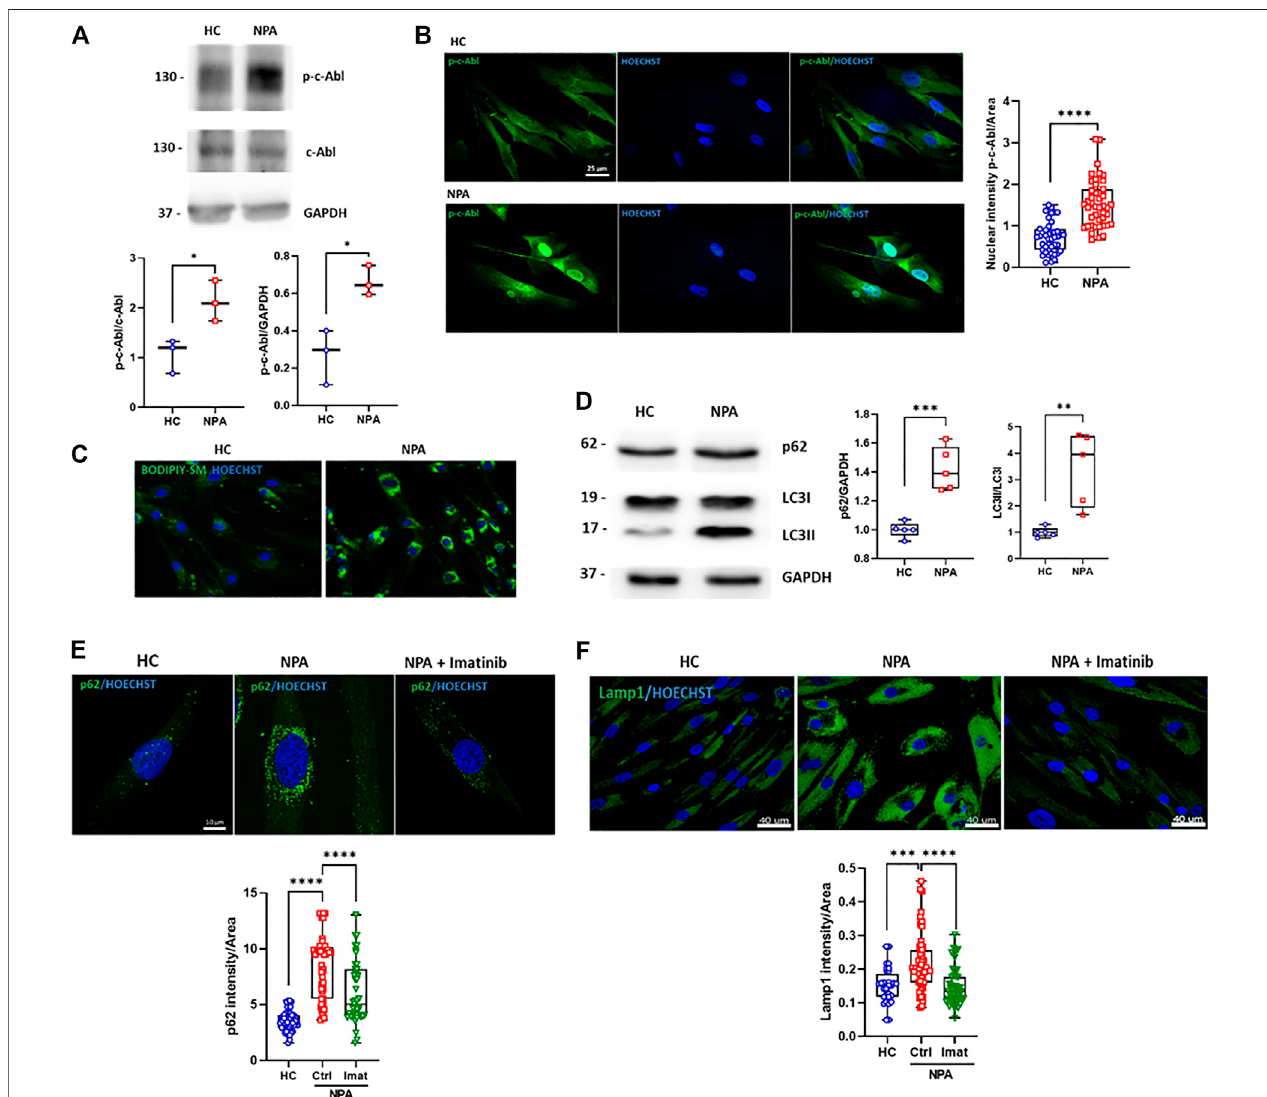
FIGURE 1 | c-Abl activation regulates autophagy and lysosomal alterations in NPA fi broblasts. (A) Human fi broblasts homogenates from NPA patient and healthy control (HC) subjects (50 μ g protein/lane) were used to measure p-c-Abl levels. The graph shows quanti fi cations of p-c-Abl levels normalized by GAPDH and c-Abl expression. The data shown are from three independent experiments. Student ’ s t -test: * p < 0.05. (B) HC and NPA fi broblasts were fi xed and immunostained using an anti-p-c-Abl Tyr412 antibody (green) and Hoechst staining for nucleus (blue). For each condition, n = 15 cells were measured by experiment; three independent experiments were performed. Student ’ s t -test: **** p < 0.0001. (C) HC and NPA fi broblasts were incubated with BODIPY-SM to con fi rm sphingomyelin accumulation. Theimagesweretakenwitha×40objectivelens. (D) Homogenatesfrom fi broblastsfromNPApatientandhealthycontrol(HC)subject(50 μ gprotein/lane)wereusedto measurep62andLC3IIlevels.Thegraphshowsquanti fi cationsofproteinlevelsnormalizedbyGAPDHandLC3Iexpression,respectively.Theimageisrepresentativeof fi ve independent experiments. Student ’ s t -test: ** p < 0.01; *** p < 0.001; (E) HC and NPA fi broblasts were treated with imatinib (10 μ M) for 24 h, fi xed, and immunostained using an anti-p62 antibody (green) and (F) anti-Lamp1 (green). Hoechst staining for the nucleus (blue). For each condition, n = 10 – 18 cells were measured by experiment; three independent experiments were performed. ANOVA, Tukey post-hoc : *** p < 0.001; **** p < 0.0001. In the box-and-whisker plots, the center line denotes the median value, edges are upper and lower quartiles and whiskers show minimum and maximum values.